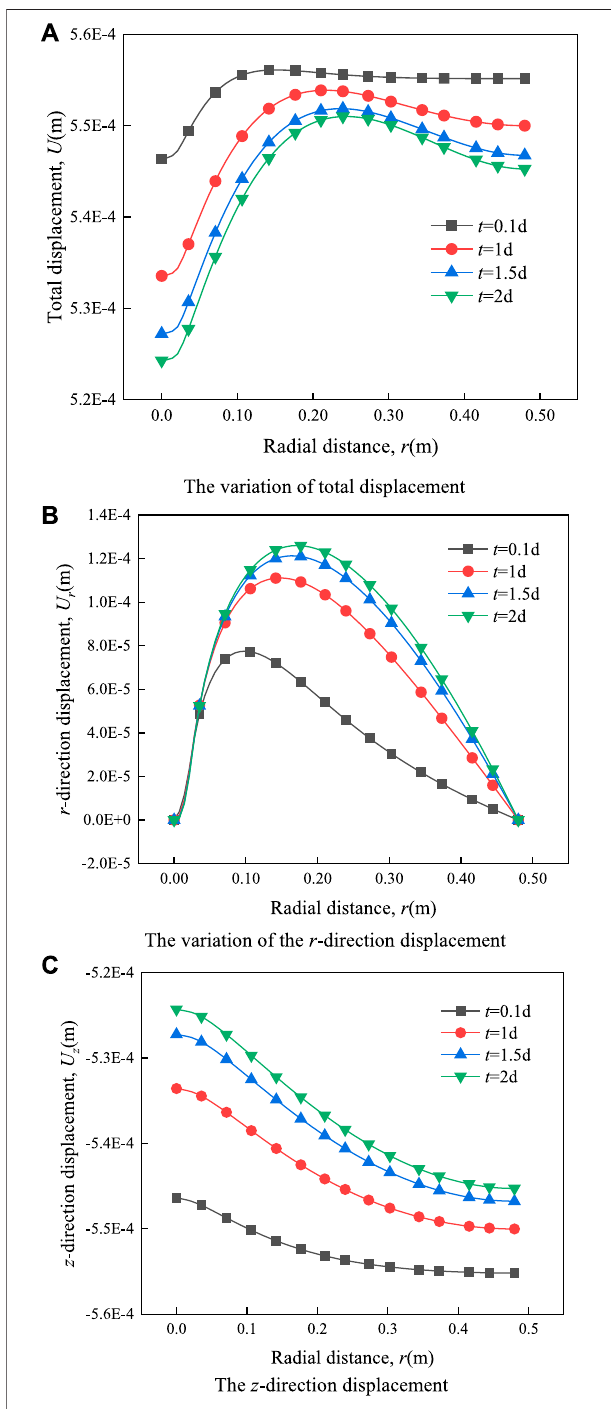
FIGURE13| Thevariationlawofthedisplacementwithradialdistanceat different times at height z = 0.25 m.